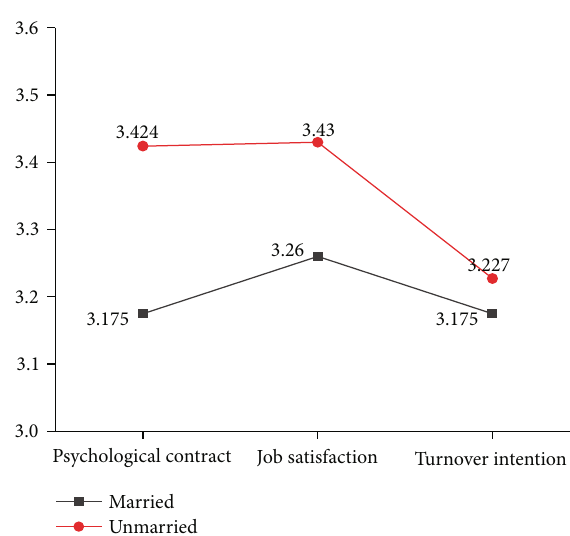
Figure 4: Comparison of the mean values of various variables in di ff erent marriage status.